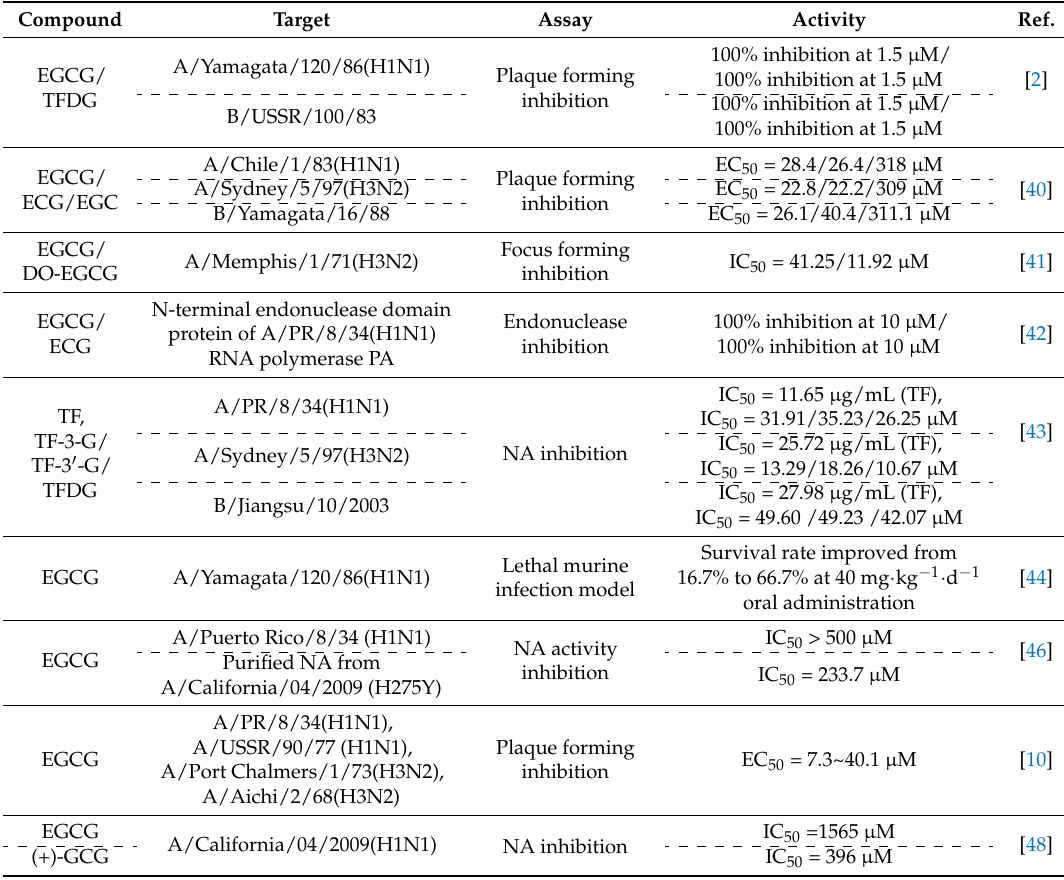
Table 4. Summary of Antiviral Activity of Catechins on influenza